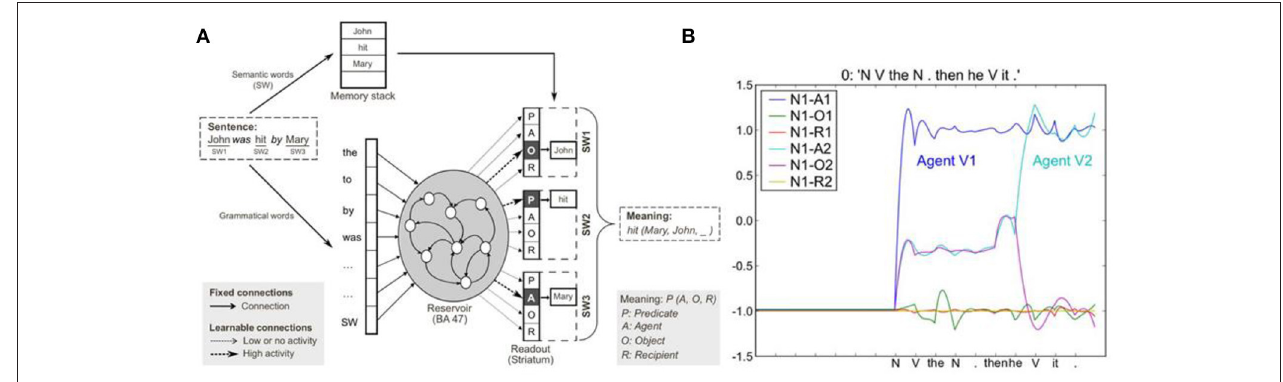
FIGURE 3 | Sentence comprehension model. (A) Grammatical construction processing in the reservoir framework. Semantic and grammatical words (i.e., open and closed class words, respectively) are separated on input. Semantic words (SW) are stored in a memory stack. Grammatical words and a single input for all SWs are inputs to the reservoir (analogous to prefrontal cortex area BA47). During training, input sentences are presented word-by-word, and readout units (corresponding to striatum) are forced to the corresponding coded meaning (i.e., SW1-Object, SW2-Predicate, SW3-Agent). In testing, readout units code the predicted role(s) of each semantic word, forming the coded meaning. The meaning [i.e., hit(Mary, John, _)] can be reconstructed from the coded meaning, as SWs in memory stack are reassigned to the thematic roles (predicate, agent, object, recipient) identified in the read-outs. (B) Activation of readout neurons coding the semantic role of the first noun (N1) in the mini-discourse “John threw the boomerang. Then he caught it.” The readout neurons indicate that the first noun, John, is the agent of action 1, and the agent of action 2 (from Hinaut and Dominey,